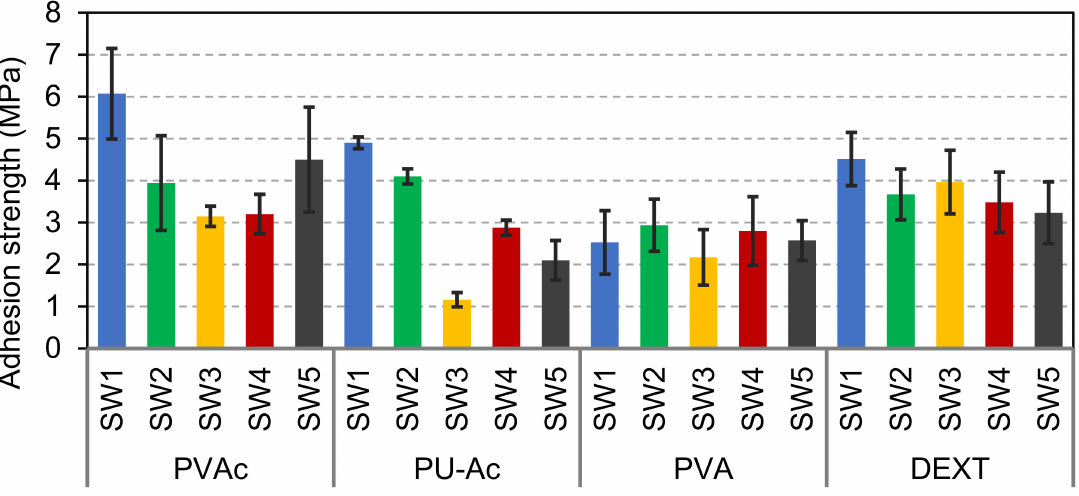
Figure 14. Adhesion strength of the coatings applied on wood pre-coated with PVAc- or PU-Ac, PVA, and DEXT- silica